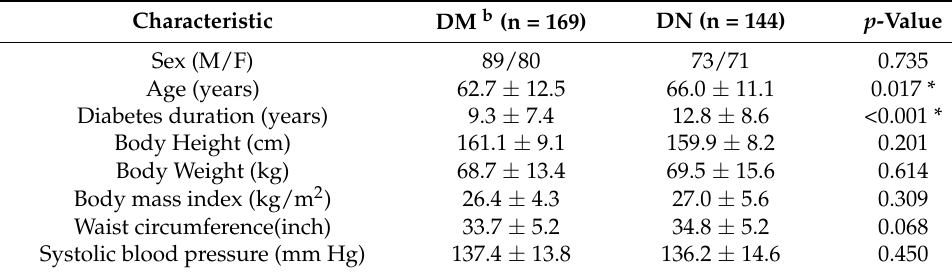
Table 1. Demographics and clinical characteristics of participants.